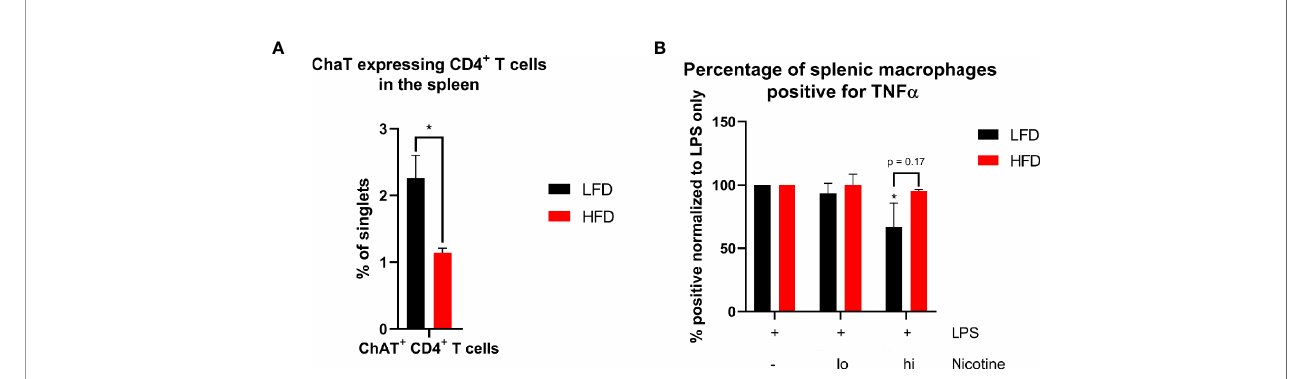
FIGURE 9 | Analysis of essential components of signal transduction of the in fl ammatory re fl ex in the spleen. Occurrence of ChAT + CD4 + T cells in the spleen of lean and obese mice (A) . Statistics: Comparison of lean and obese mice was achieved by an unpaired two-tailed Student ’ s t -test. Comparison of TNF- a + splenic macrophages after LPS stimulation with or without different concentrations of nicotine treatment to the control (B) were analyzed using a two-way ANOVA with repeated measurements followed by an uncorrected Fisher ’ s LSD test. * indicates p ≤ 0.05. Sample sizes: Each group at for each analysis and condition: n = 5. Data are displayed as mean ±